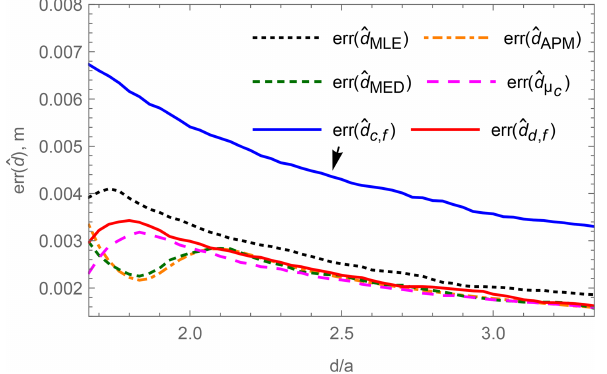
Figure 8. Simulated mean localization error at different positions d of six localization methods.